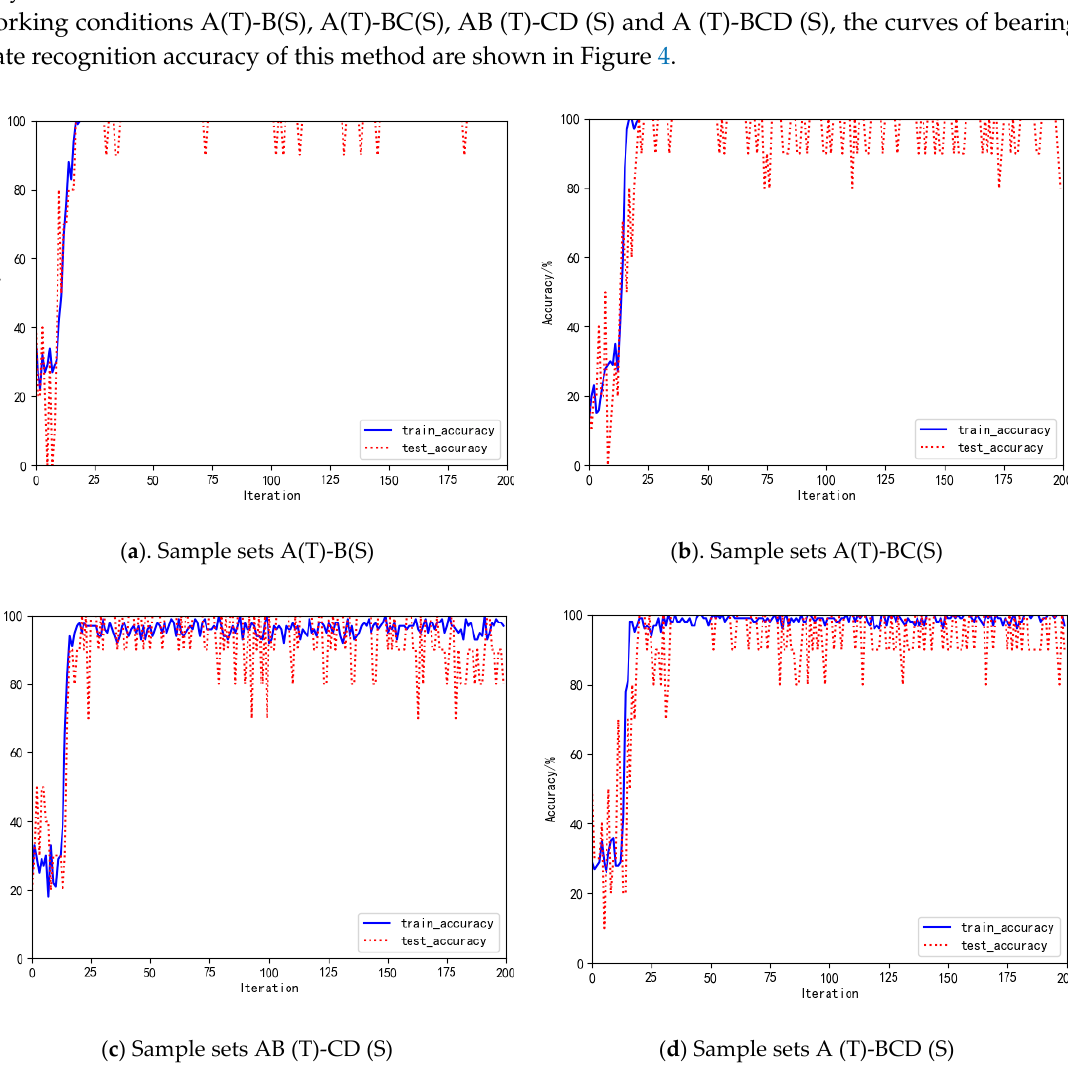
Figure 4. Bearing state recognition accuracy curve under working conditions A(T)-B(S), A(T)-BC(S), AB (T)-CD (S) and A (T)-BCD (S), respectively.